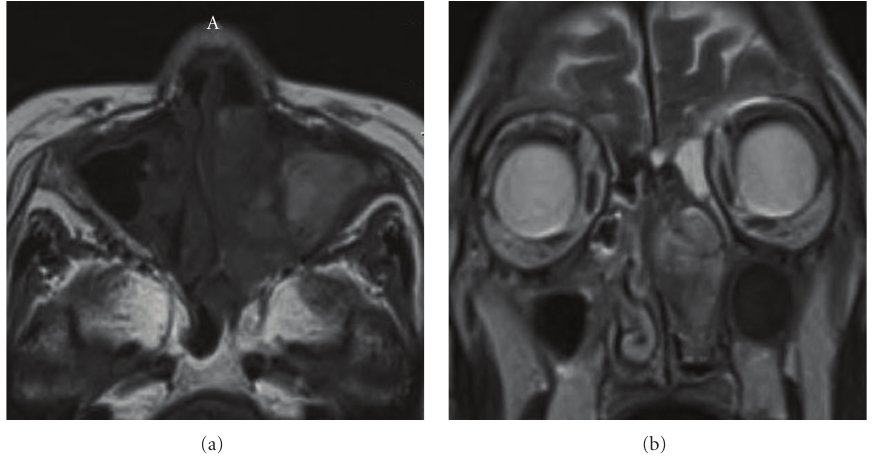
Figure 2: Horizontal (a) and axial (b) magnetic resonance imaging (MRI) showed a nasal tumor in the left nasal cavity with a hypointense signal on T1-weighted images, and a moderately hyperintense signals on T2-weighted images. This signal was di ff erent from that of the left maxillary sinus